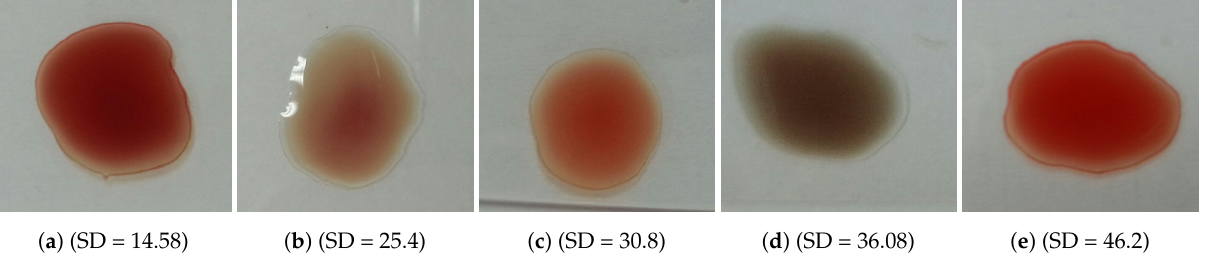
Figure 4. Blood samples without agglutination and their standard deviation values (negative).